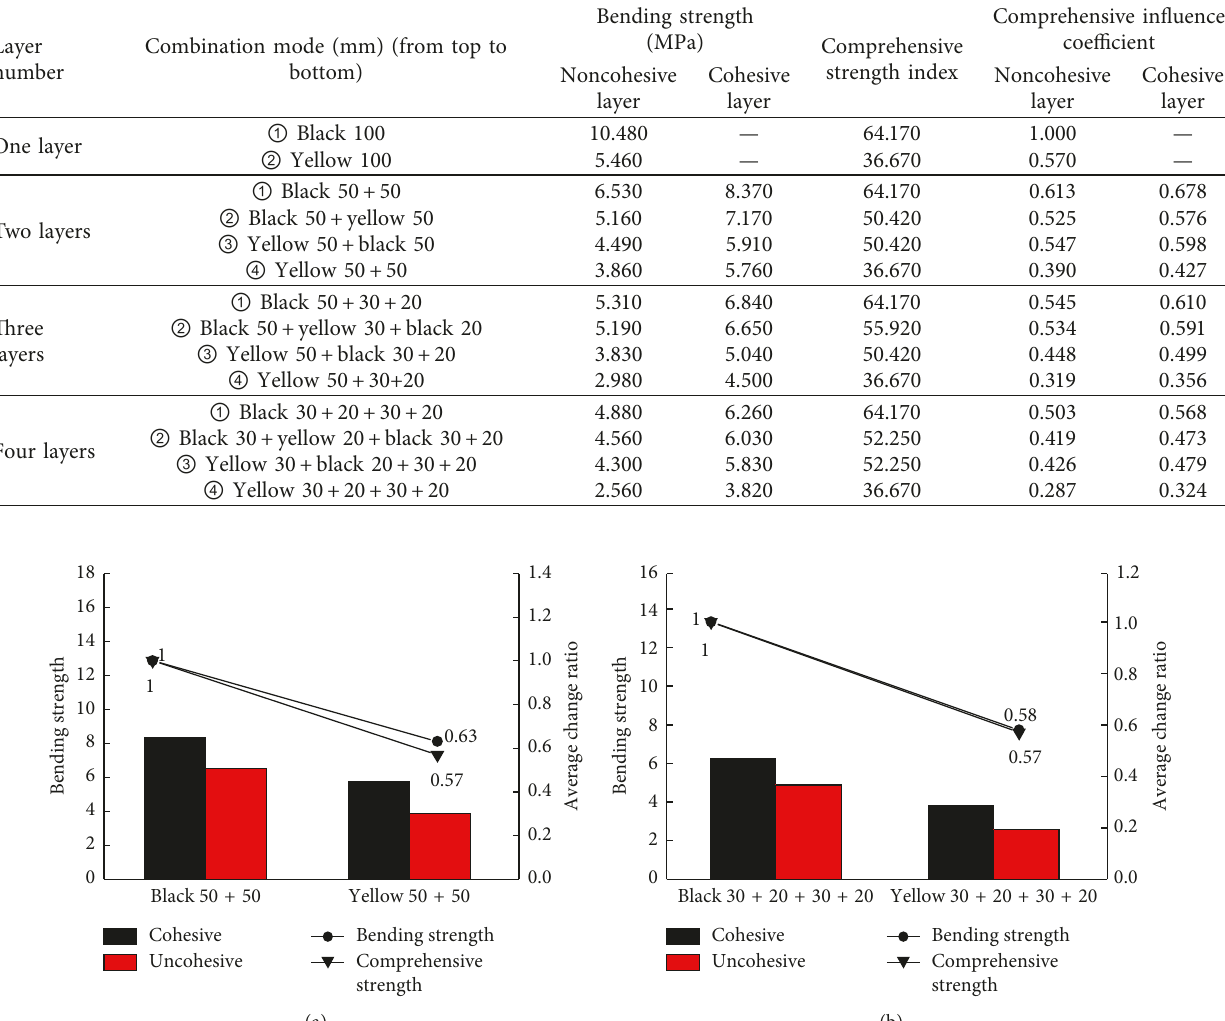
Table 2: Comparison of bending strengths of combined models of different lithologies.